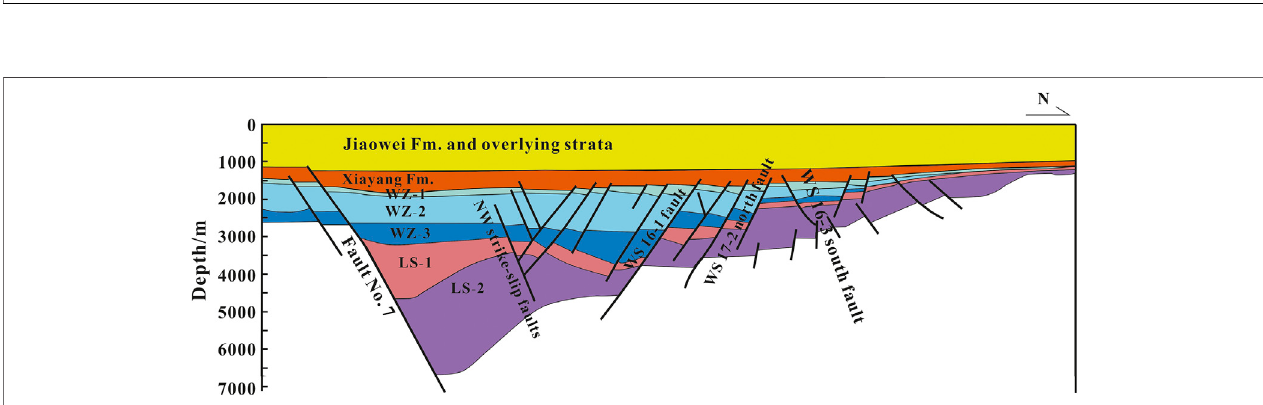
FIGURE 11 | Geological pro fi le of the Wushi Sag in south-north trending (modi fi ed after (Yuan et al., 2020)). Fm. = Formation, WZ = Weizhou Formation, LS = Liushagang Formation.